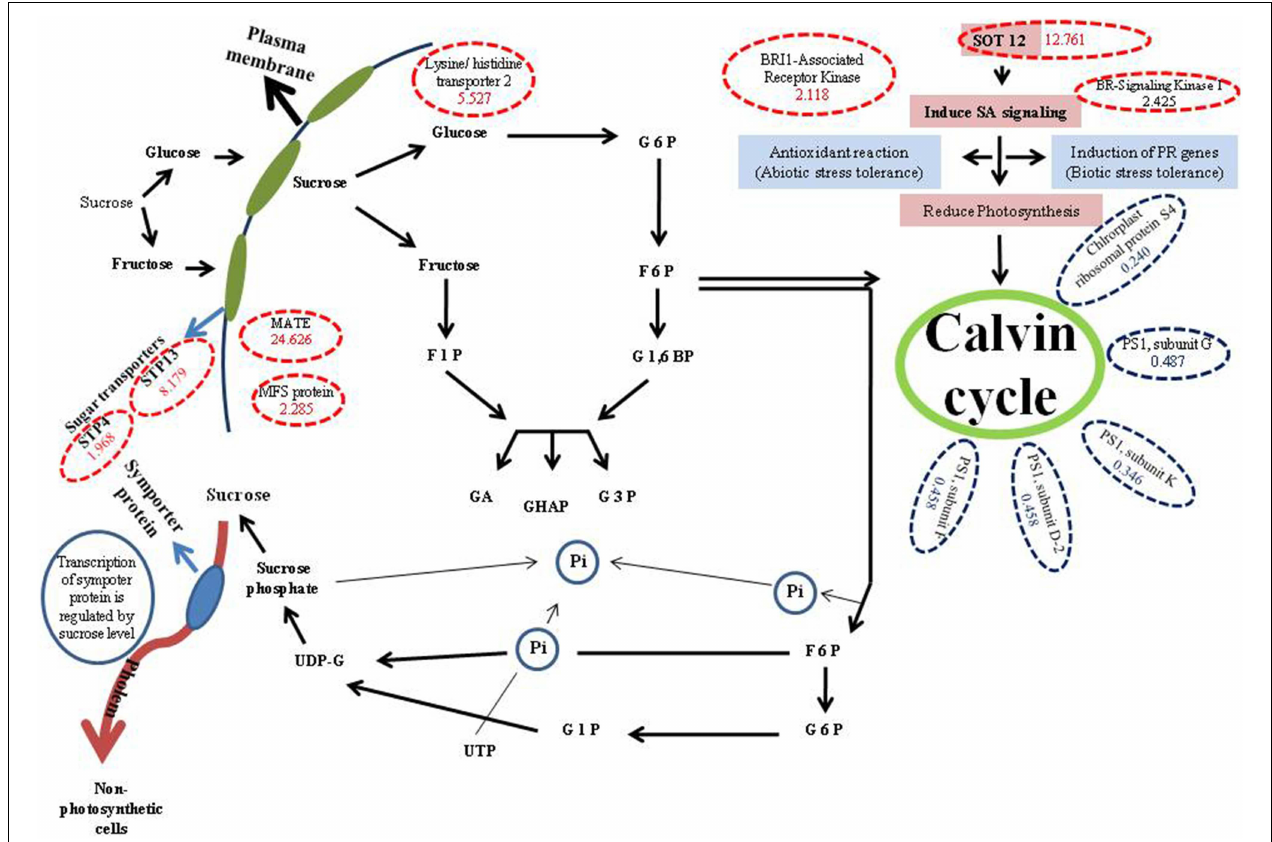
Glyceraldehyde 3 phosphate; G1P, Glucose 1 phosphate; UDP-G, UDP-Glucose; SA, Salicylic acid; Red dotted circles show, up regulated proteins (in brackets fold values of proteins in 0-Fe conditions compared to control are demarked); Blue dotted circles show down regulated proteins (in brackets fold values of proteins in 0-Fe conditions compared to control are